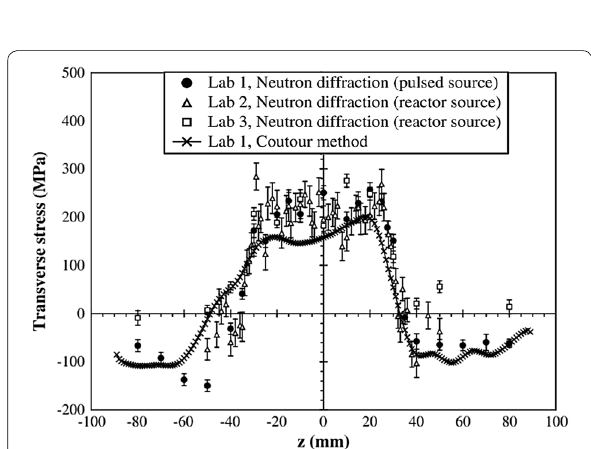
Figure 45 Residual stress values at the transverse direction of the workpiece